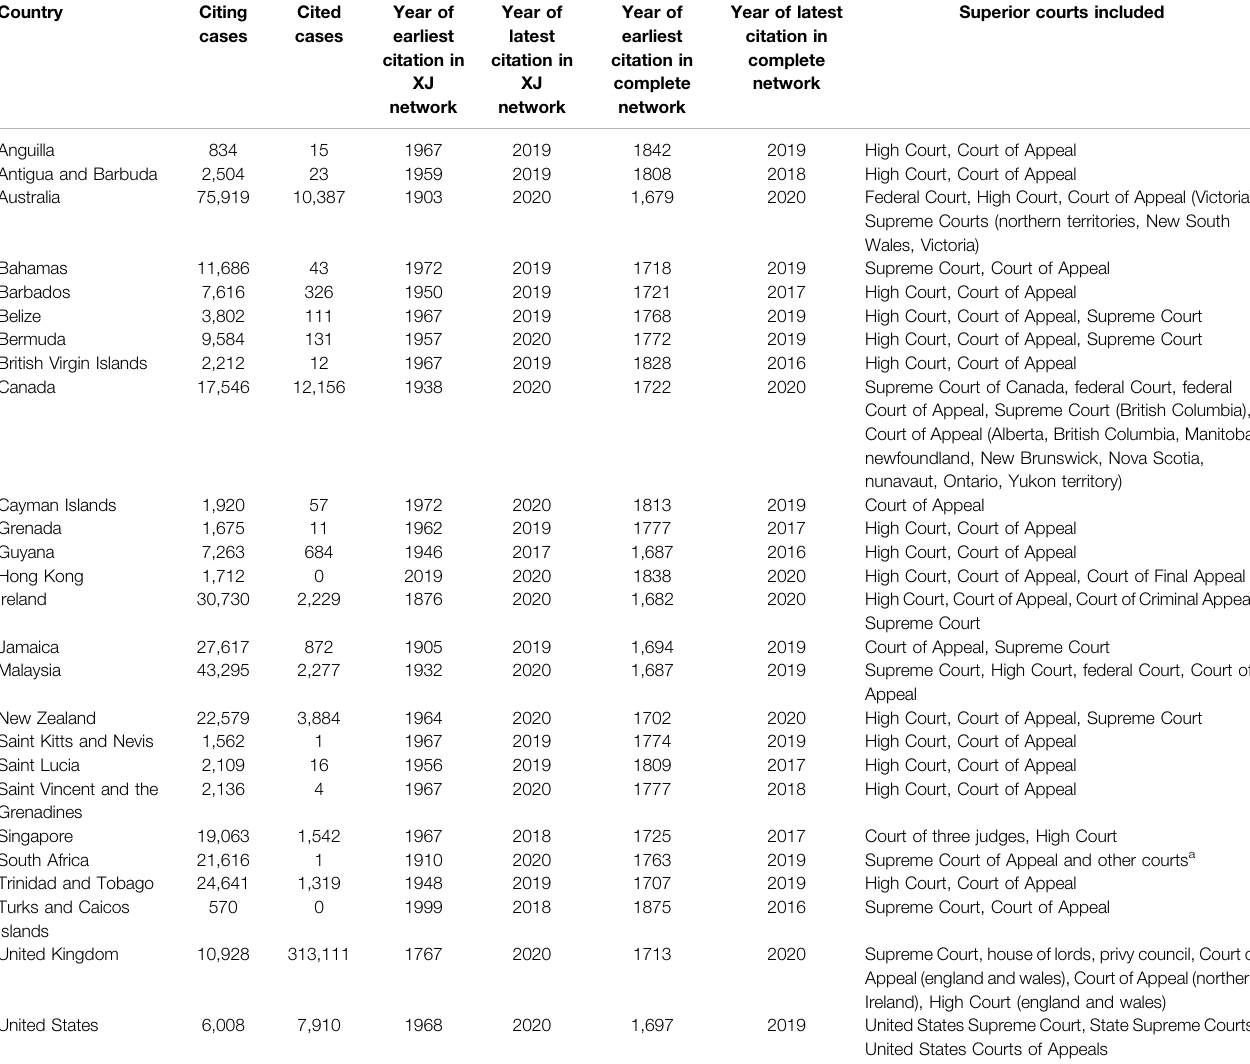
TABLE1| Compositionofthecross-jurisdictional(XJ)networkshowingthecourtsincludedinouranalysis. CitingCases isthenumberofuniquecasesthathaveatleastone outward edge.Forexample,cases fromtheUnited Kingdomcited toatotal of10,928foreigncases. Cited Cases isthenumber ofuniquecases withat leastoneinward edge. For example, 313,111 cases from the United Kingdom were cited by other countries in the data. The year of the earliest and latest citations are provided for both networks. For the United Kingdom, the year of the earliest case with either an inward or outward edge in the cross-jurisdictional network is 1767 (1713 in the complete network) and the latest is 2020 (also 2020 in the complete